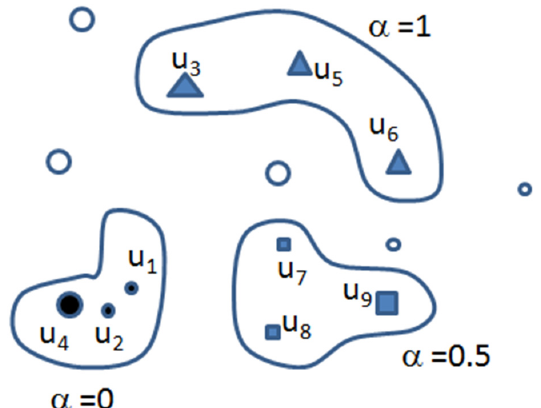
Figure 6. An example of geosocial group query that considers a set of users {u1, u2, . . . , u9} located in the places depicted by circles, squares, and triangles. The sizes of those shapes indicate the user’s interests in the query keywords. Query q requests a user group of size 3 that maximizes the ranking function. The query returns the set of users {u1, u2, u4} when α = 0 (i.e., only the group diameter is considered), the set of users {u3, u5, u6} when α = 0.5, and the set of users {u7, u8, u9} for α = 1 (i.e., only the group interest is considered). α (cid:15) [0, 1] is a parameter used to balance the group interest and the group diameter. Table 6. Geosocial group queries.